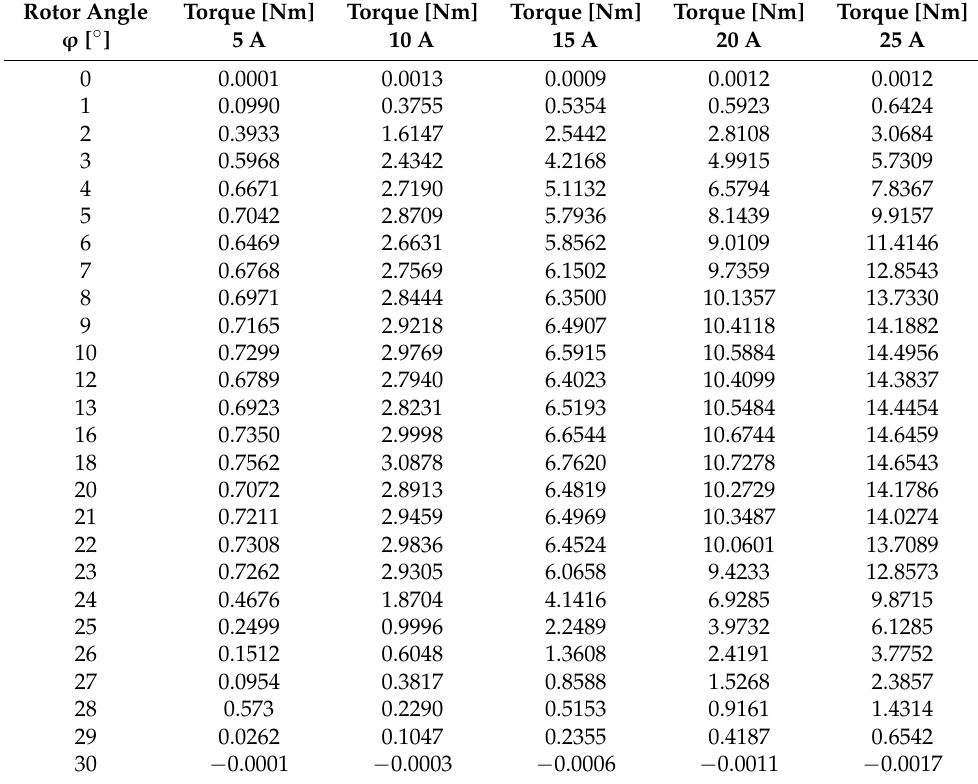
Table 5. The 8/6 motor: torque values for individual angles’ and currents’ values derived from the